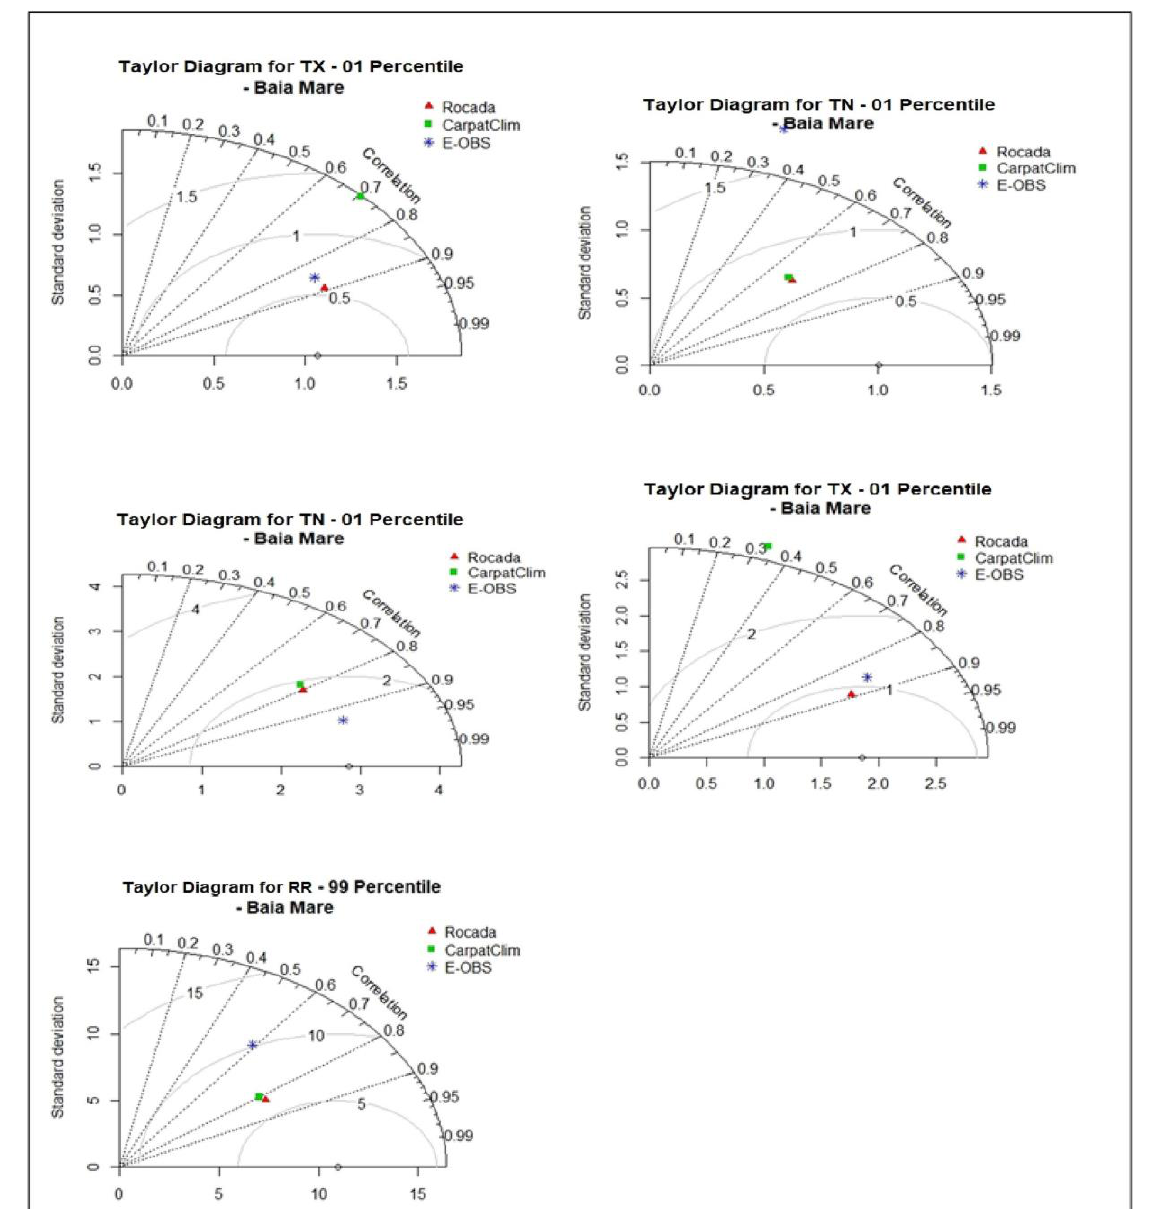
Figure 5. Taylor diagram for the 1st and 99th percentiles, the Baia Mare weather